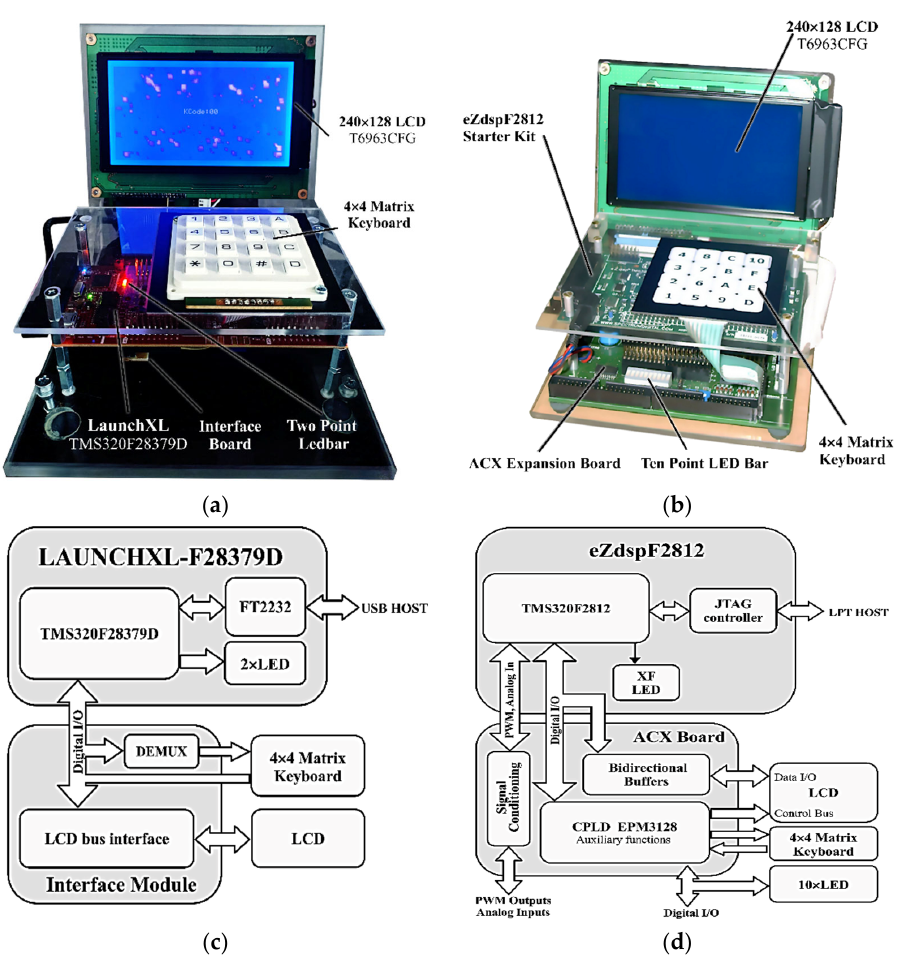
Figure 2. TMSLAB didactical module in two developed versions: ( a ) second version (the current one) based on TMS320F28379D MCU; ( b ) first version based on TMS320F2812 MCU; ( c , d ) their internal structure ‐ block diagrams, respectively.